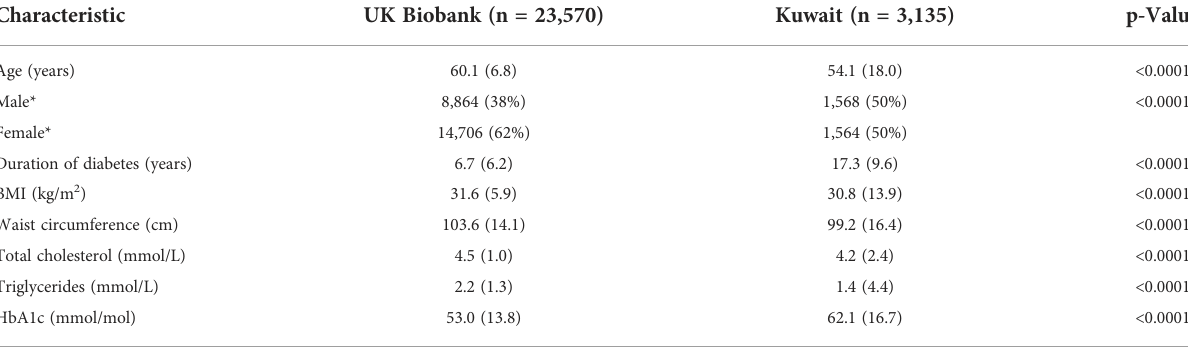
TABLE 1 Characteristics of the UK Biobank and Kuwaiti cohorts of people with type 2 diabetes.